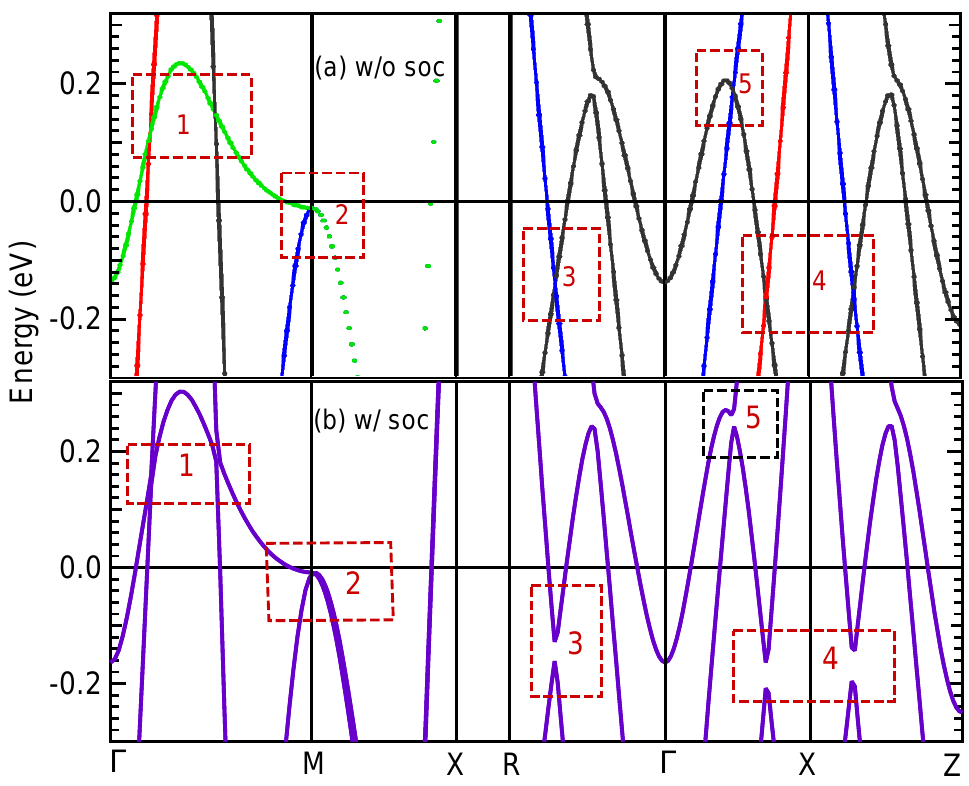
Figure 2. (Color online) Calculated electronic band structure of LaSiS compound with and without SOC interaction along the high symmetry lines on the BZ k-path Γ − M − X − R − Γ − X − Z . ( a ): Irreducible representation of Calculated bulk band structure without SOC. Colors have meaning of band symmetries discussed in the text. ( b ): Calculated bulk band structure with SOC effect. Red dotted boxes are the topological behaviors as discussed in the text. The solid black line at zero indicates the Fermi